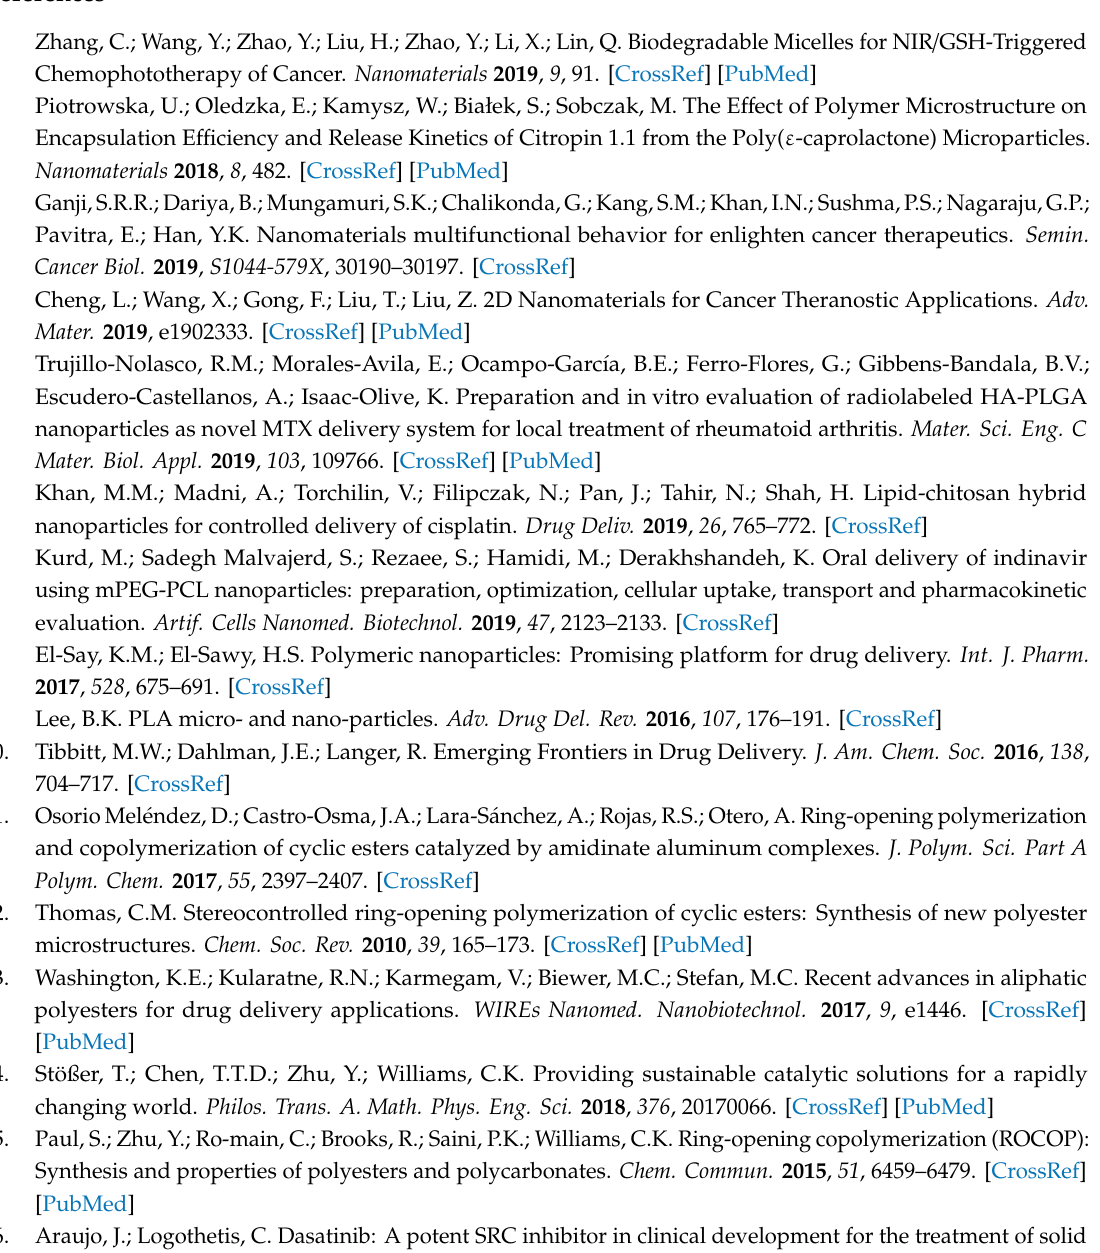
pH = 5; Figure S6. E ff ect of DAS and DAS-loaded PLA NPs on cell viability in MDA-MB-231 and